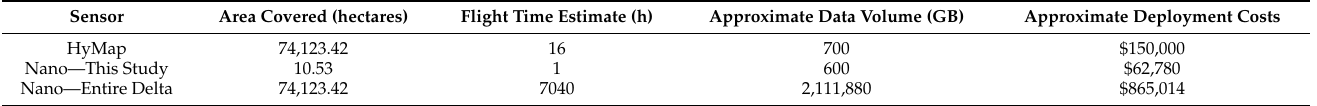
Table 7. Nano and HyMap Operational Information and Cost